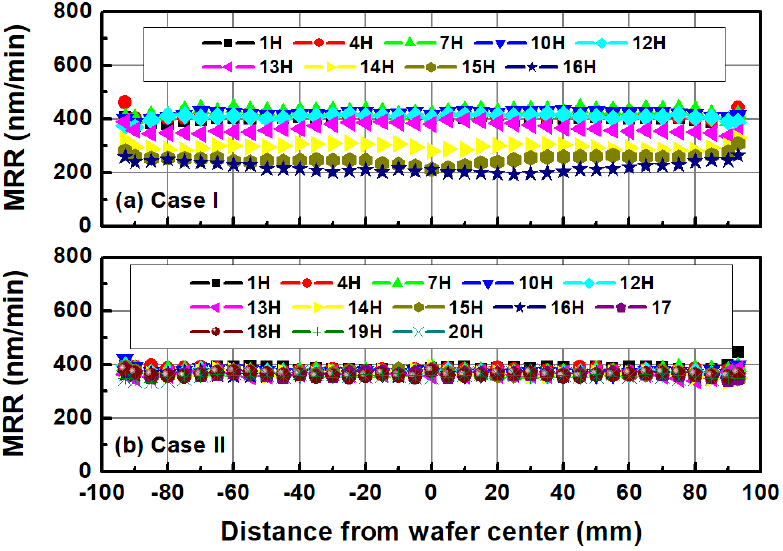
Figure 14. Material removal rate distribution as a function of conditioning time: ( a ) Case I and ( b ) Case II.